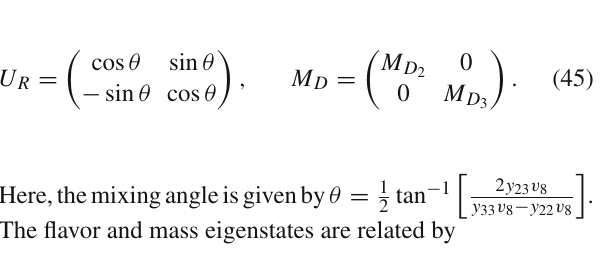
Fig. 12 Variation of relic density as a function of DM mass ( M D with fixed Z (cid:2) mass and g BL for different set of mass splittings between M D and M D . Right panel corresponds to the behavior of relic density 2 3 = M by varying Z (cid:2) mass for M D D 3 . The benchmark for the masses of 2